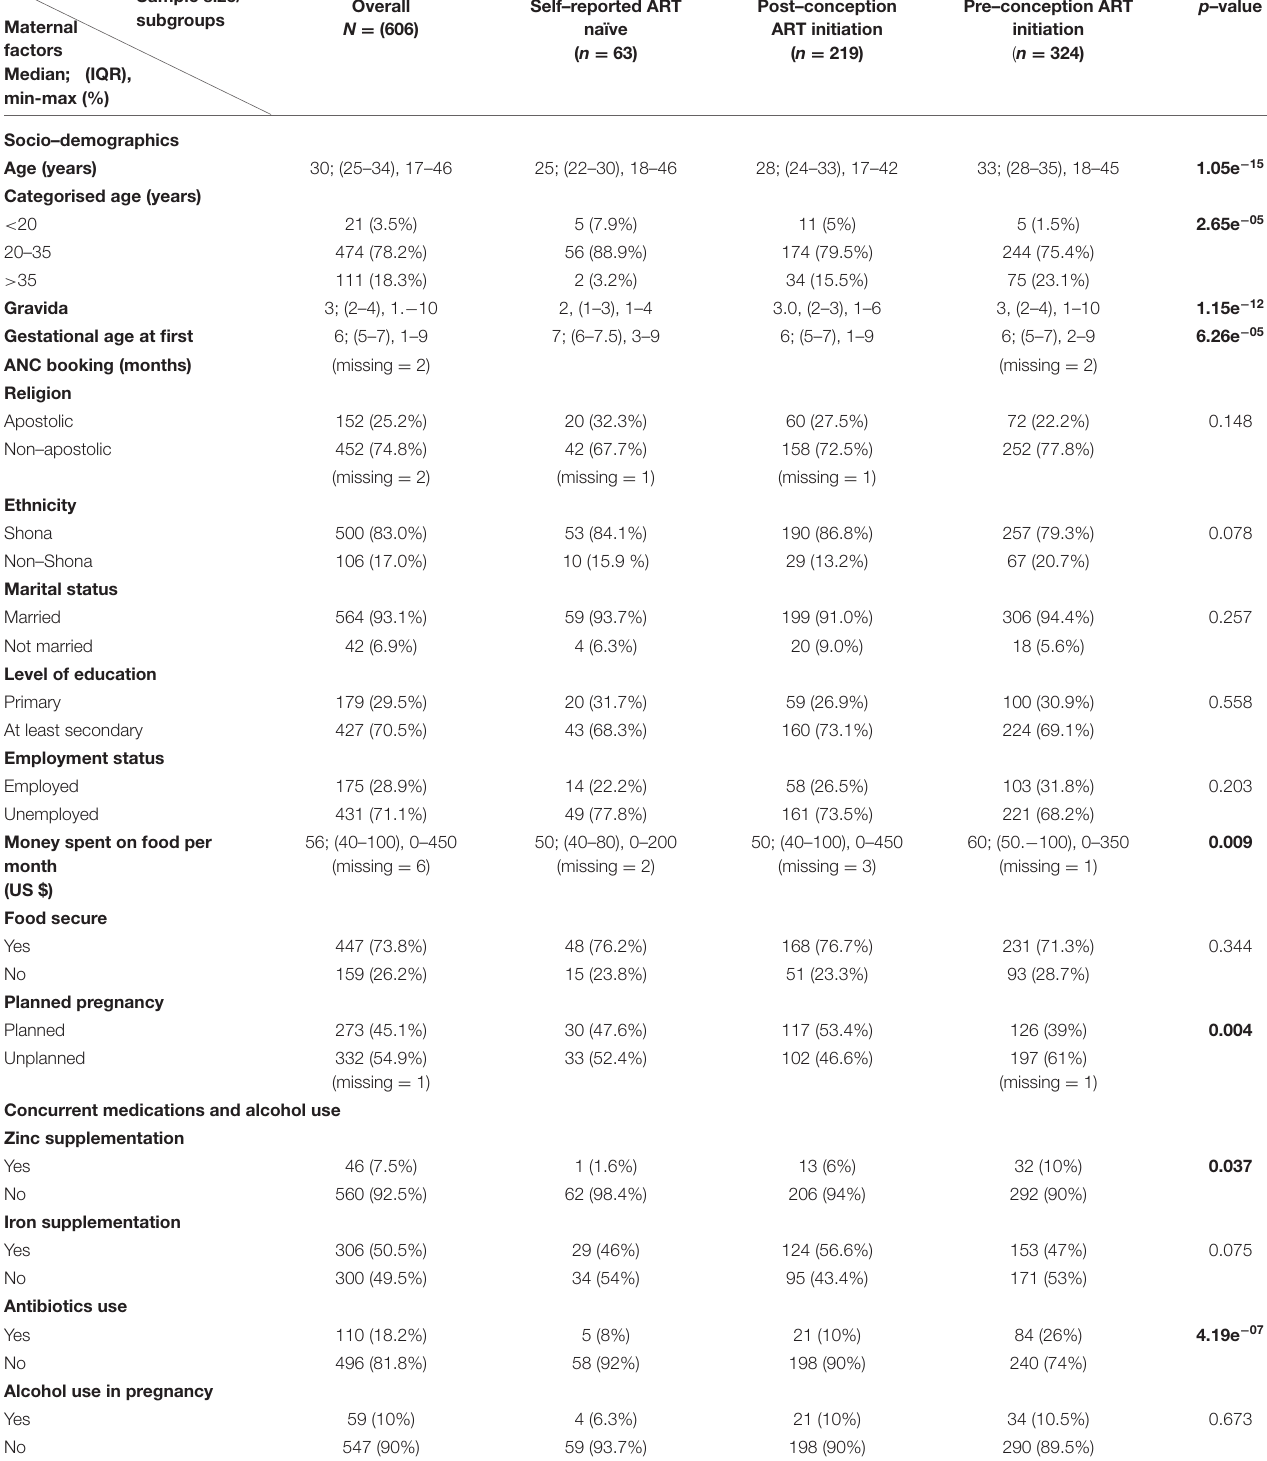
TABLE 1 | Characteristics of the study